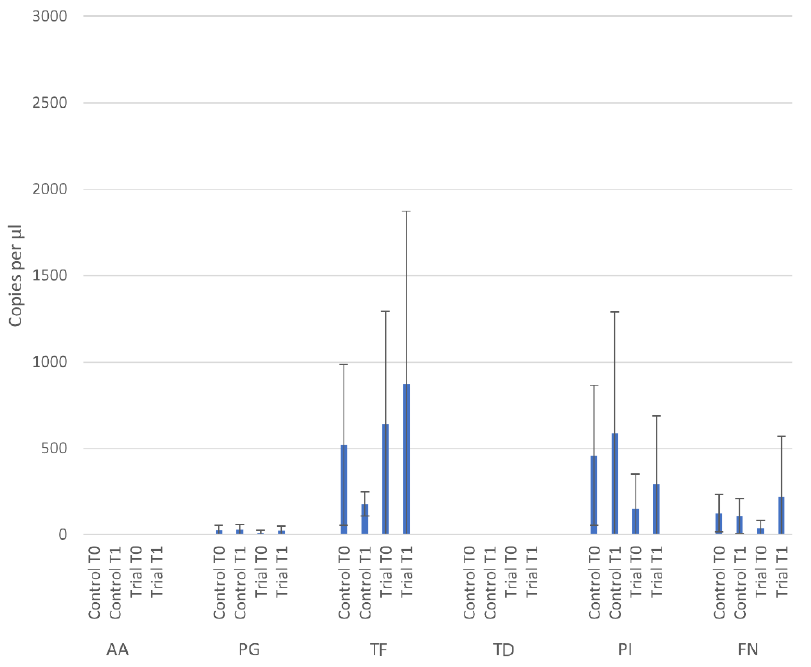
Figure 2. Number of copies/microlitre for the bacteria tested in the study (this figure shows the data reported in Table 4).